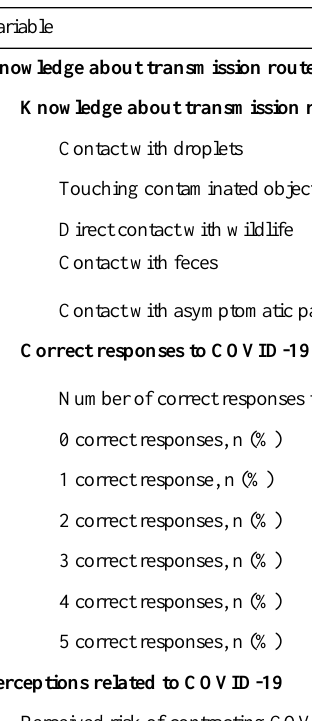
Table 3. Responses to survey items measuring individual-level variables